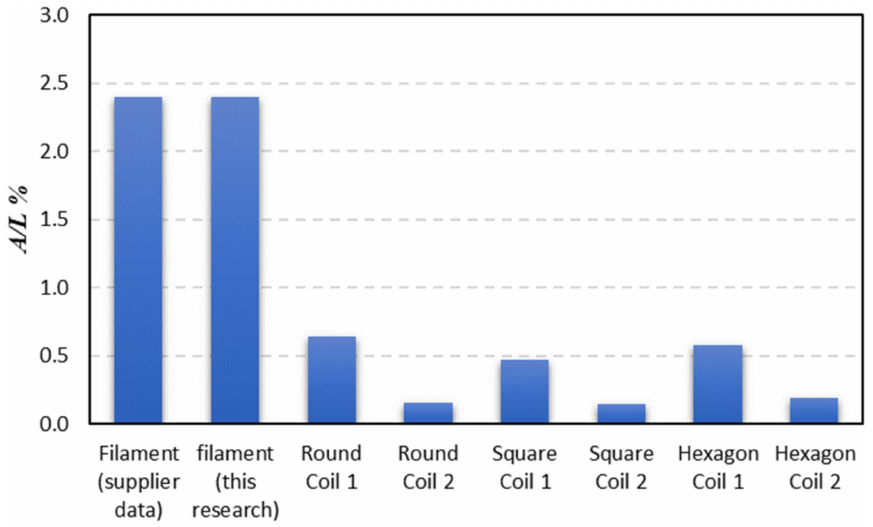
Figure 7. Variation of A / L percentage in filaments and